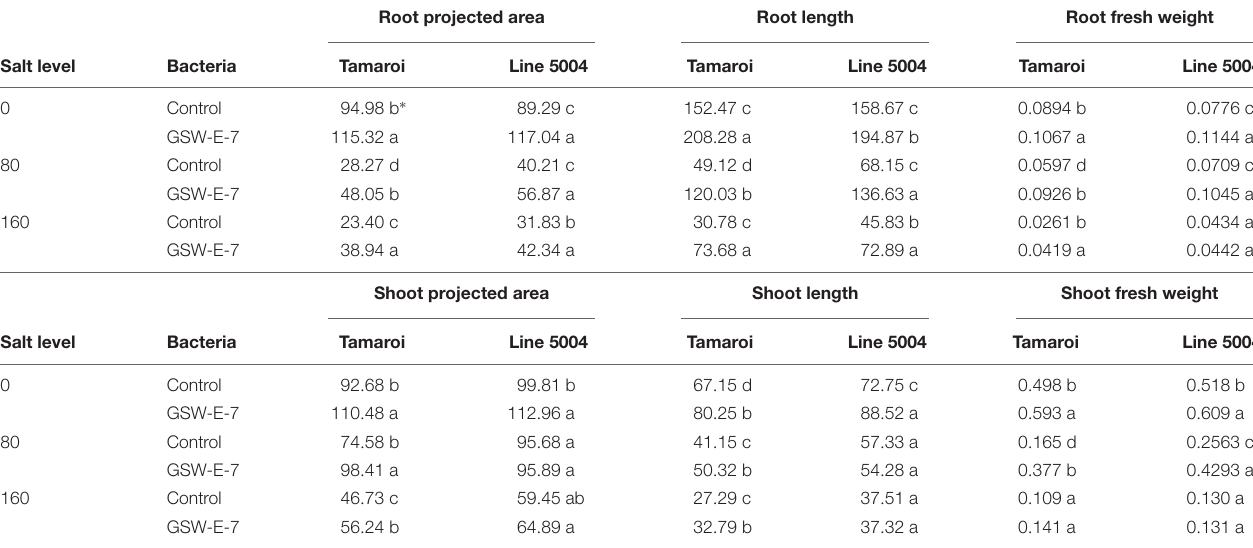
TABLE 3 | Effect of inoculation with GSW-E-7 strain on root and shoot characteristics [fresh weight (gm), projected area (mm 2 ), and length (mm)] in two durum wheat genotypes under different salinity levels after 3 weeks in a hydroponic culture.